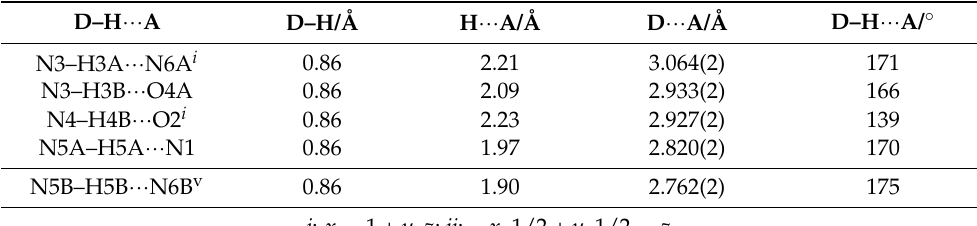
Table 3. Geometric parameters of hydrogen bonds for (1:2) trimethoprim:theophylline. ( D and A are the donor and the acceptor atoms, respectively.)